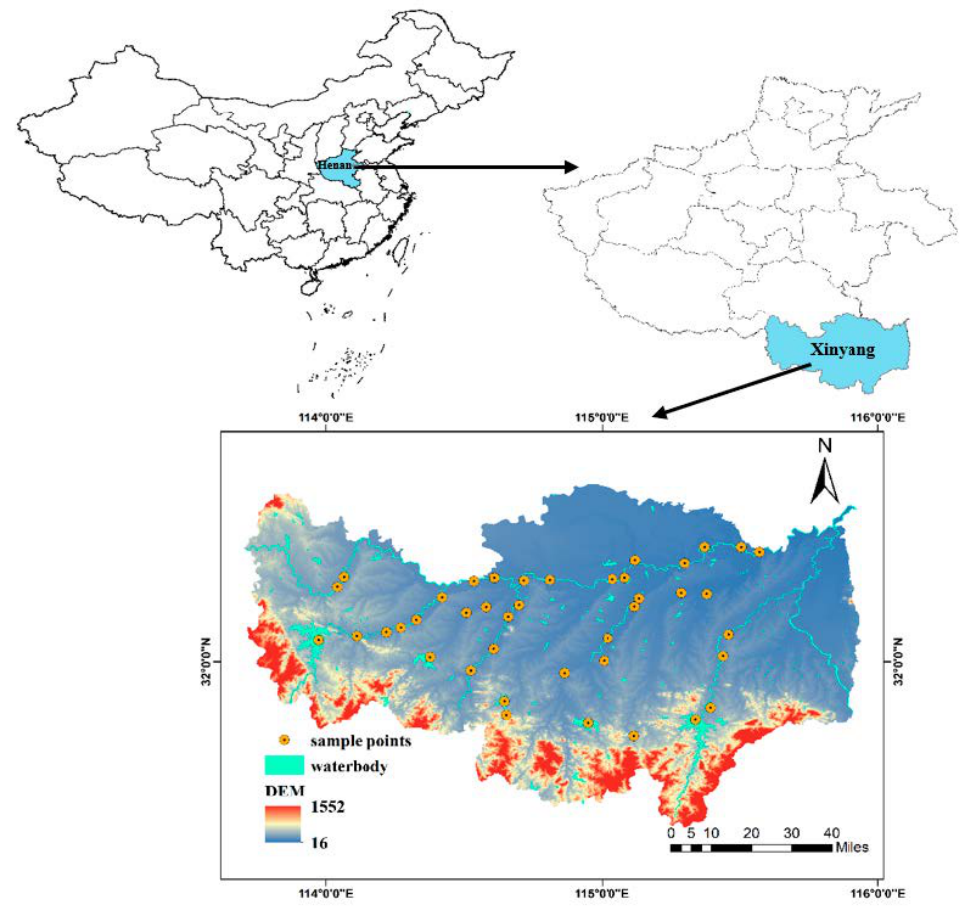
Figure 3. The study area. Table 2. Spectral bands and acquisition dates of Landsat-8 OLI in the study.